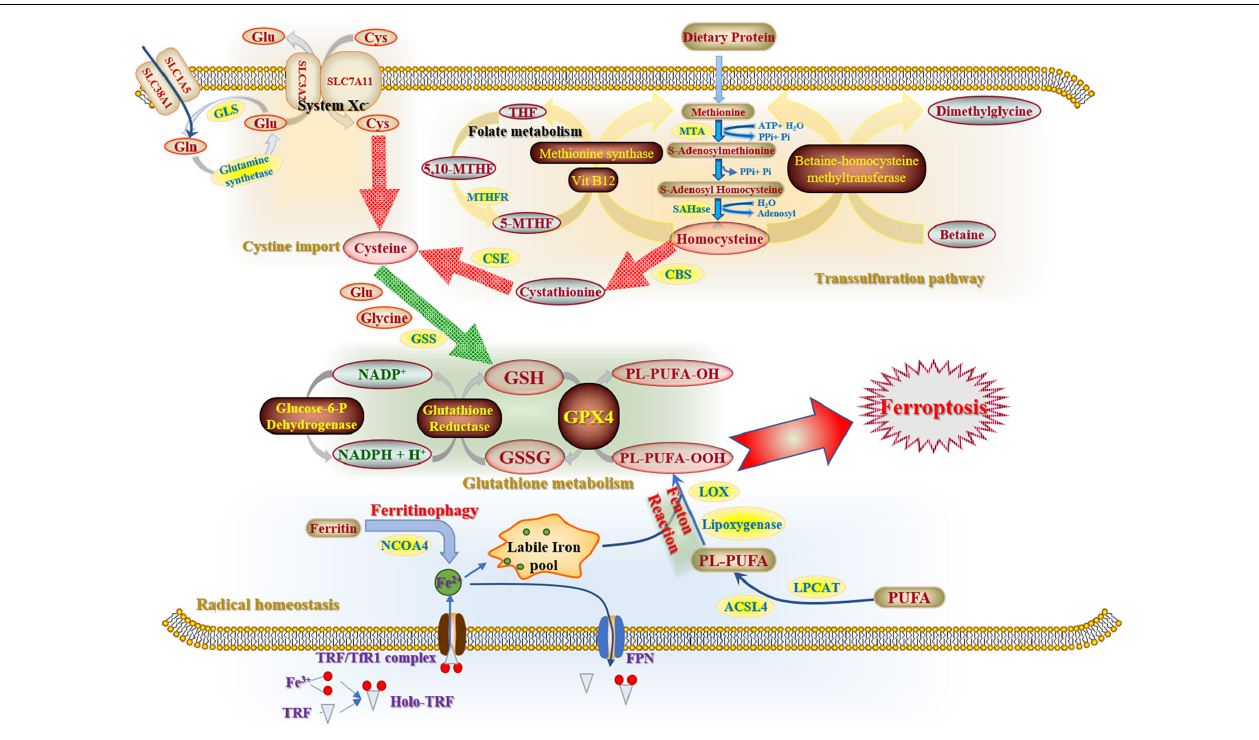
FIGURE 1 | Three main components of ferroptosis mechanisms. Cysteine metabolism, consisting of cystine import and transsulfutation pathway, refers to a compensation method of cellular cysteine that contributes to the biofunction of glutathione (GSH) cycle in cytoplasm. As the key factor of antioxidative system, glutathione metabolism removes excessive ROS with the participation of GPX4 and NADPH. Radical homeostasis is the essential link to exacerbate cell destroy. Labile iron pool is accumulated excessively as a substrate of Fenton reaction for ROS generation by the uptake of ferrous iron and degradation of